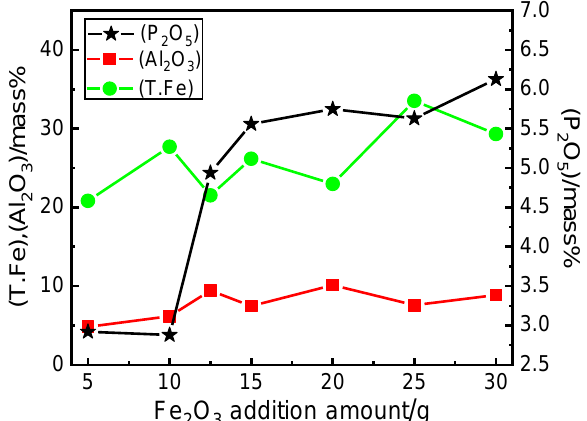
Figure 6. Effect of the Fe 2 O 3 addition amount on the contents of P 2 O 5 , Al 2 O 3 and T.Fe in the slag after dephosphorization.